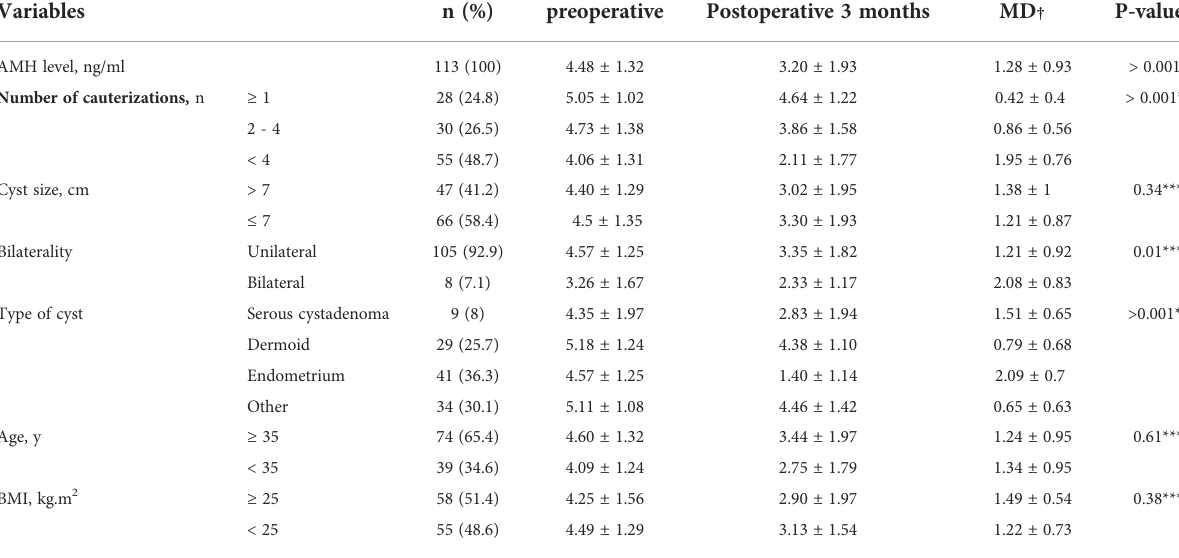
TABLE 2 Comparison of serum AMH preoperative and 3 months postoperative in different groups.